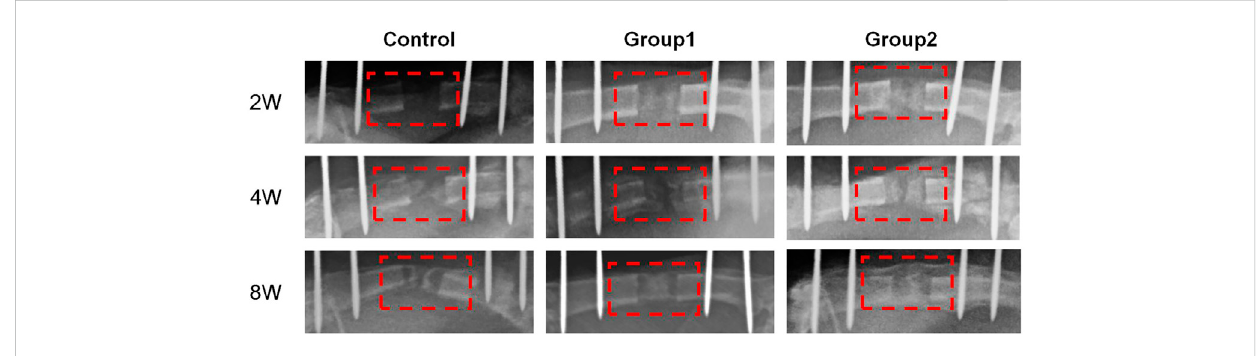
FIGURE 8 X-ray photos of femoral samples at different time points.